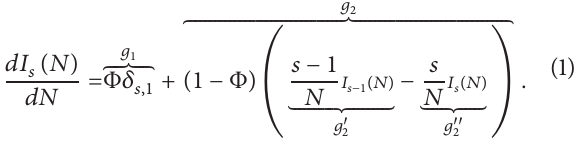
with 𝛾 and 𝛼 both tunable from 2 to ∞ . For the second case of Φ the exponents are fixed to 𝛾 = 2 and 𝛼 = 1 ,